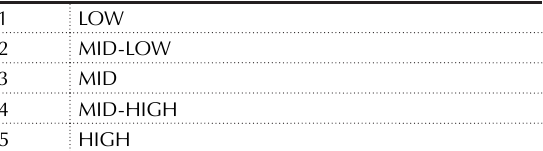
Table 1. Scale used for qualitative